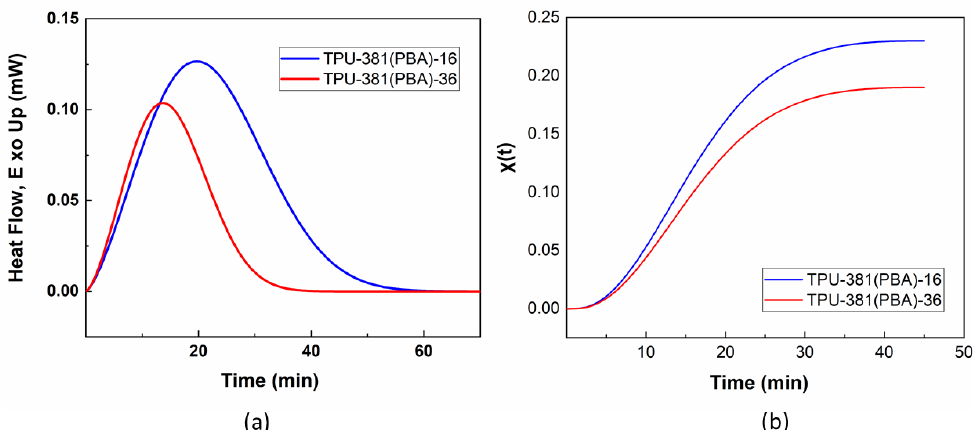
Figure 3. Isothermal crystallization exotherms ( a ) and curves 𝜒(𝑡) ( b ) of TPU-381(PBA)-16 (blue line) and TPU-381(PBA)-16 (red line) taken at 25 °C.